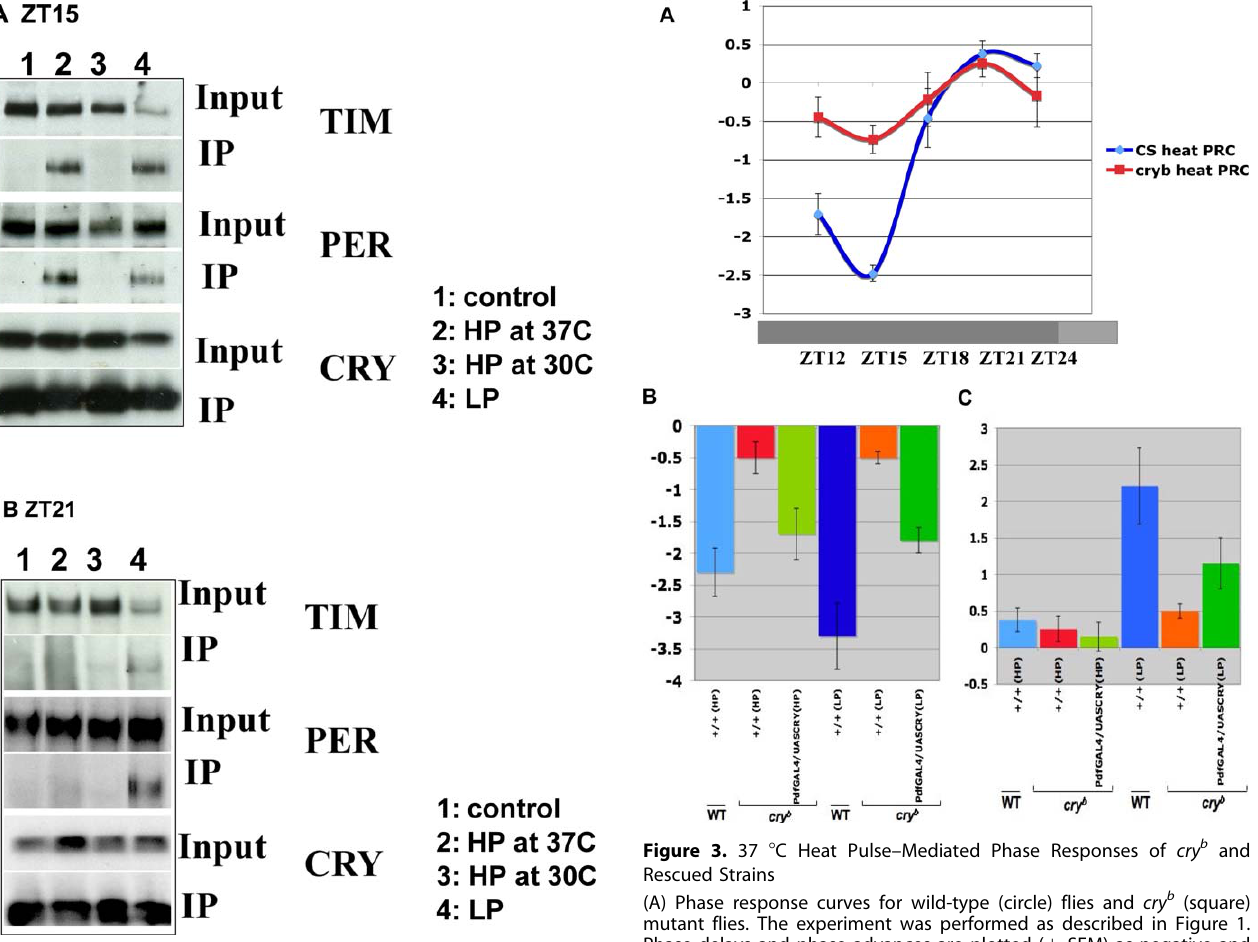
Figure 2. CRY Interacts with PER/TIM in a 37 8 C Heat Pulse–Dependent Manner at ZT15 but Not at ZT21 Heat- and light-dependent interactions among CRY, TIM, and PER were measured three times with similar results. (A) TMC flies (Myc-CRY) were subjected to standard 12:12 LD conditions referred as control, pulsed with 37 8 C (2), pulsed with 30 8 C (3), light-pulsed (4), or not (1) for 30 min at ZT15, collected, and frozen. Head extracts (HE) were immunopreci- pitated with antibody to MYC (IP), all as previously described [20]. CRY, PER, and TIM levels were measured by Western blotting. (B) Exactly as above but pulses were at ZT21.